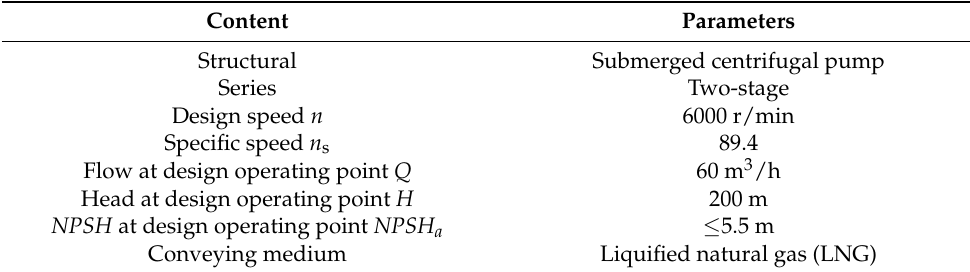
Table 1. Overall design parameters of the LNG submerged